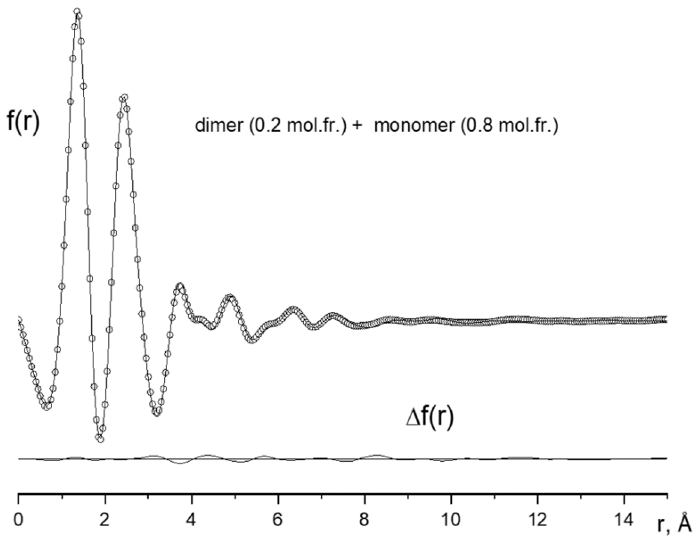
Figure 4. Experimental (points) and theoretical (lines) curves of the radial distribution f(r) and their difference ∆ f (r). difference ∆ f